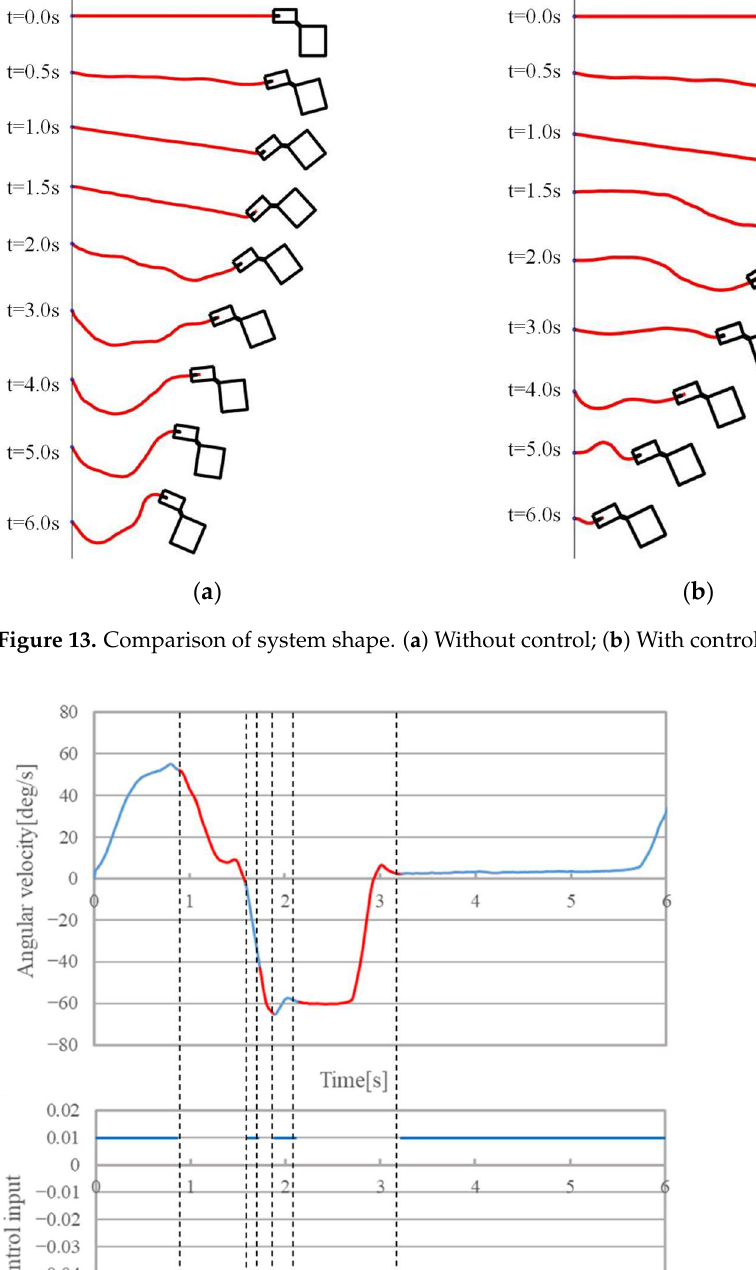
Figure 15. Time history of angular velocity and control input (numerical results).